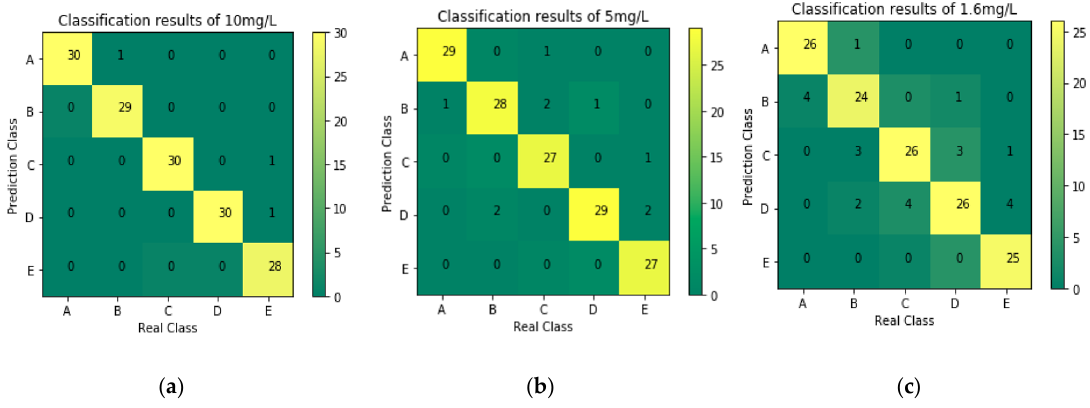
Figure 7. Classification results of contaminants at different concentrations. ( a ) Classification results of 10 mg/L; ( b ) classification results of 5 mg/L; ( c ) classification results of 1.6 mg/L. 10 mg / L; ( b ) classification results of 5 mg / L; ( c ) classification results of 1.6 mg /